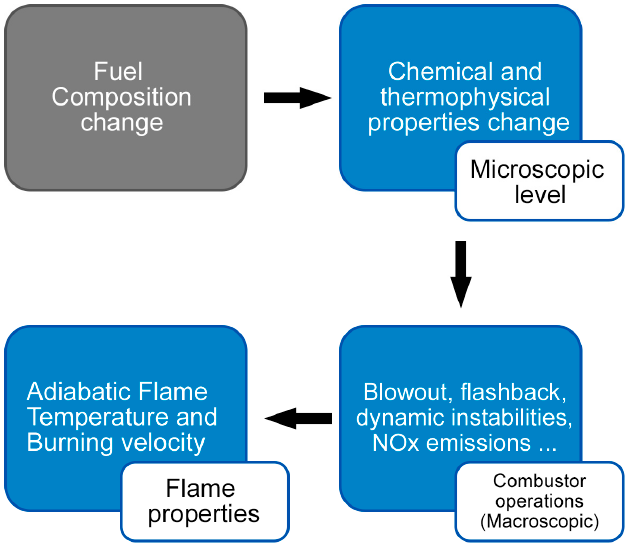
Figure 1. Analysis of fuel composition influence at different levels, adapted from [3].